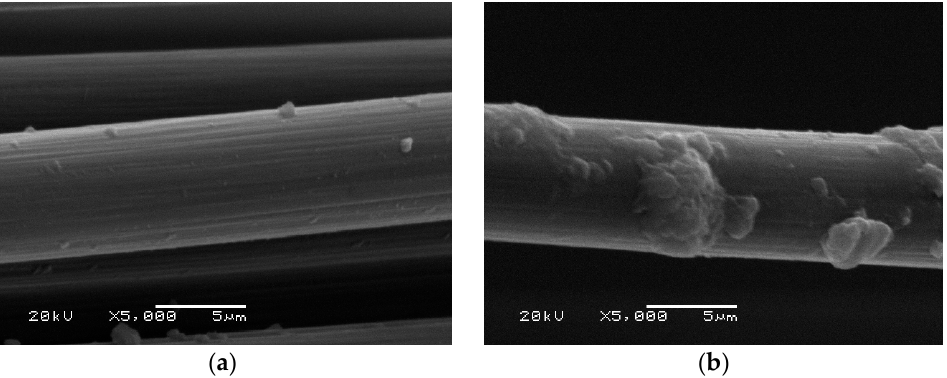
Figure 14. SEM image: Carbon fiber ( a ) as delivered; ( b ) derived from a sample based on a fly ash matrix.